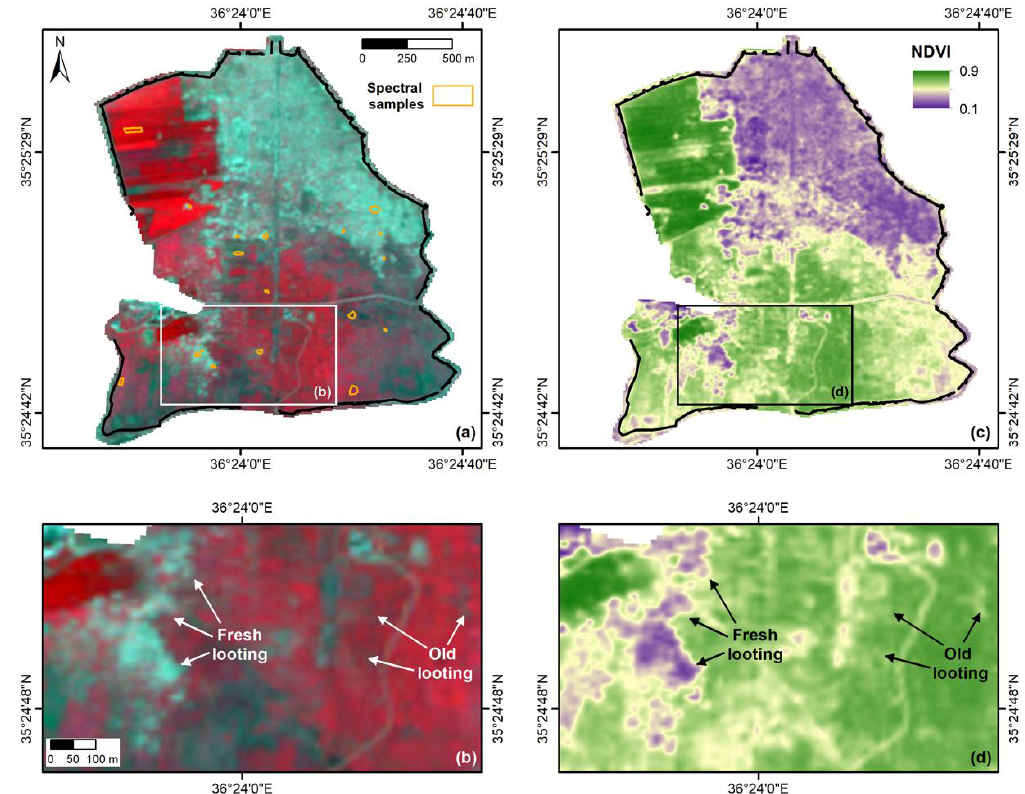
Figure 11. Archaeological looting at Apamea (Syria) captured with 10-m Sentinel-2 image (21/04/2017, i.e., nearly coeval with WorldView-2 image in Figure 10) displayed as: ( a , b ) false-colored infrared (R: Band 8—NIR; G: Band 4—red; B: Band 3—green) and ( c , d ) Normalized Difference Vegetation Index (NDVI). Zoomed views ( b , d ) highlight the marked difference in spectral signature of fresh vs. old looting features. Spectral samples reported in ( a ) were used to extract the spectral profiles showed in Figure 12. Contains modified Copernicus Sentinel-2 data 2017.